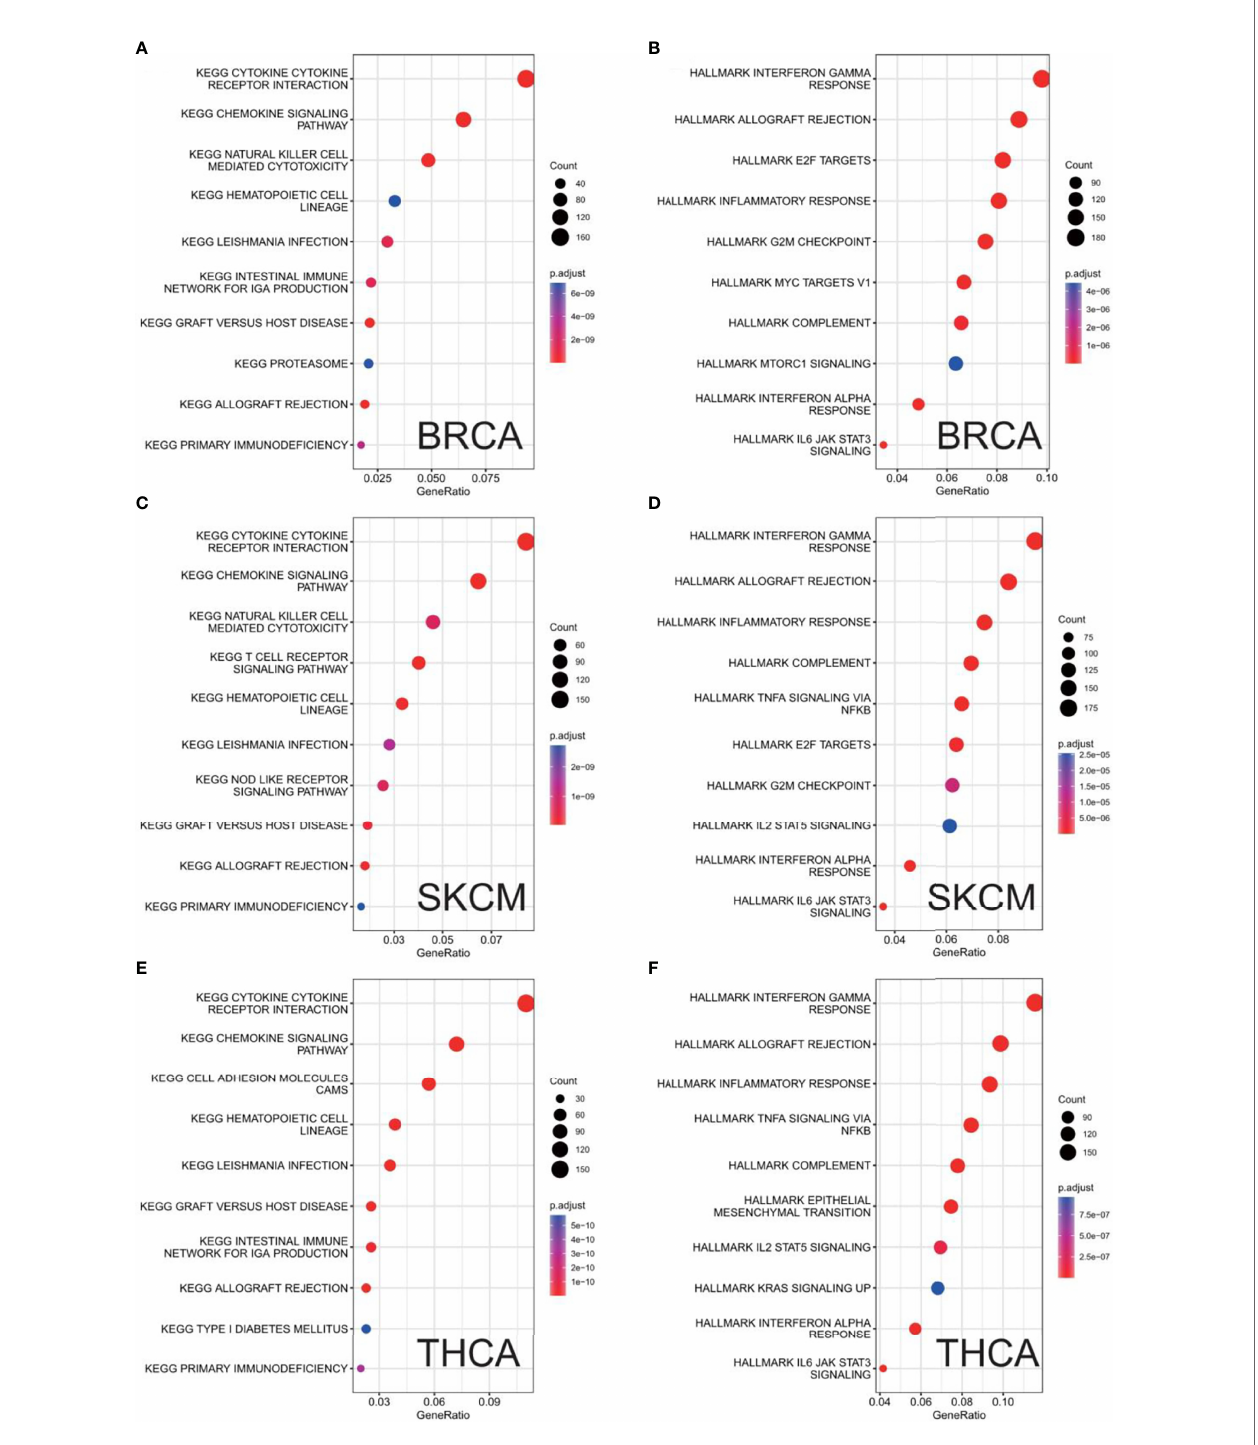
FIGURE 12 | Results of GSEA. Different KEGG and HALLMARK pathways regulated in BRCA (A, B) , SKCM (C, D) , and THCA (E, F)